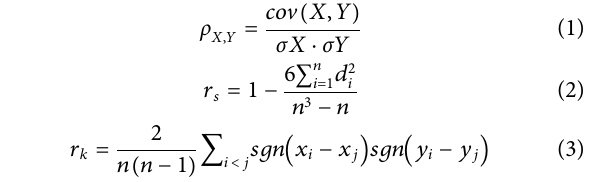
Frontiers in Earth Science |